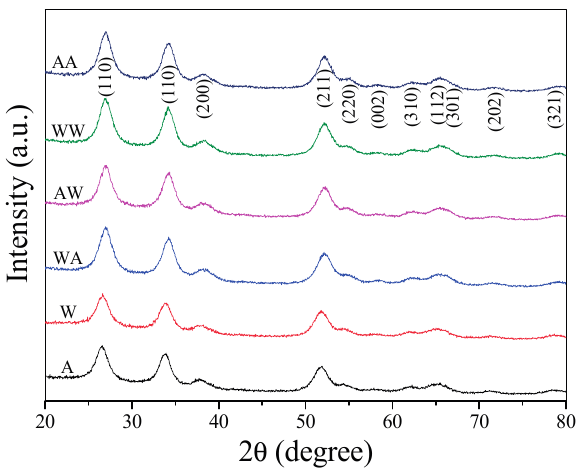
Figure 1. XRD patterns of as-prepared SnO 2 nanomaterials and films.